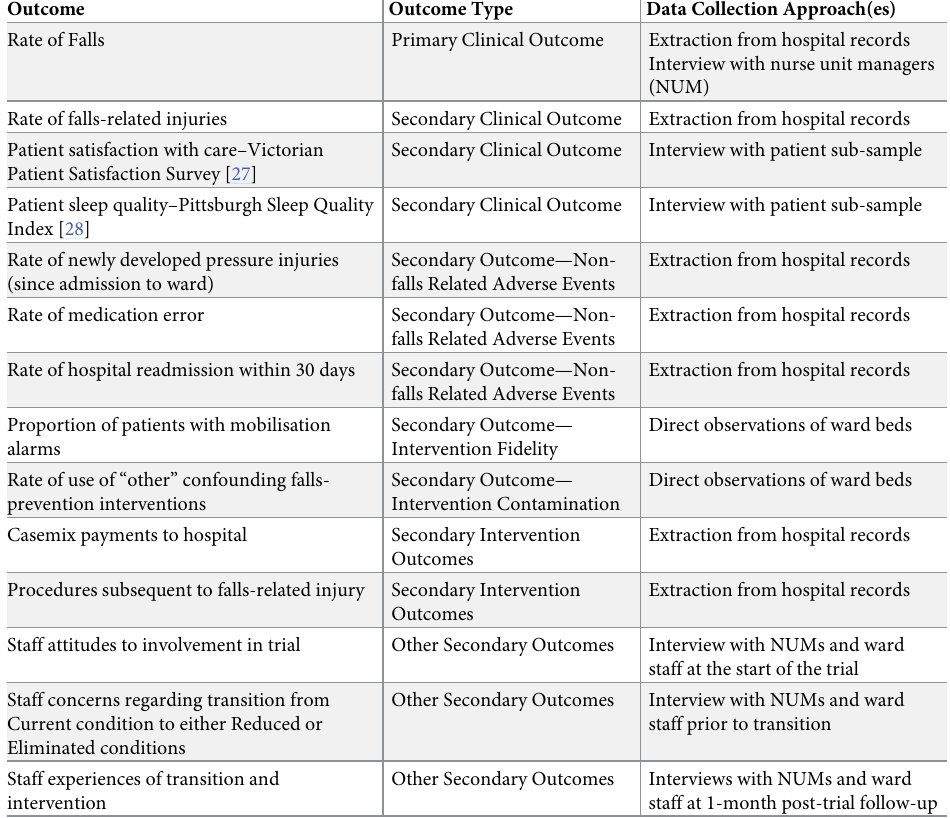
Table 1. Outcome measures and corresponding data collection